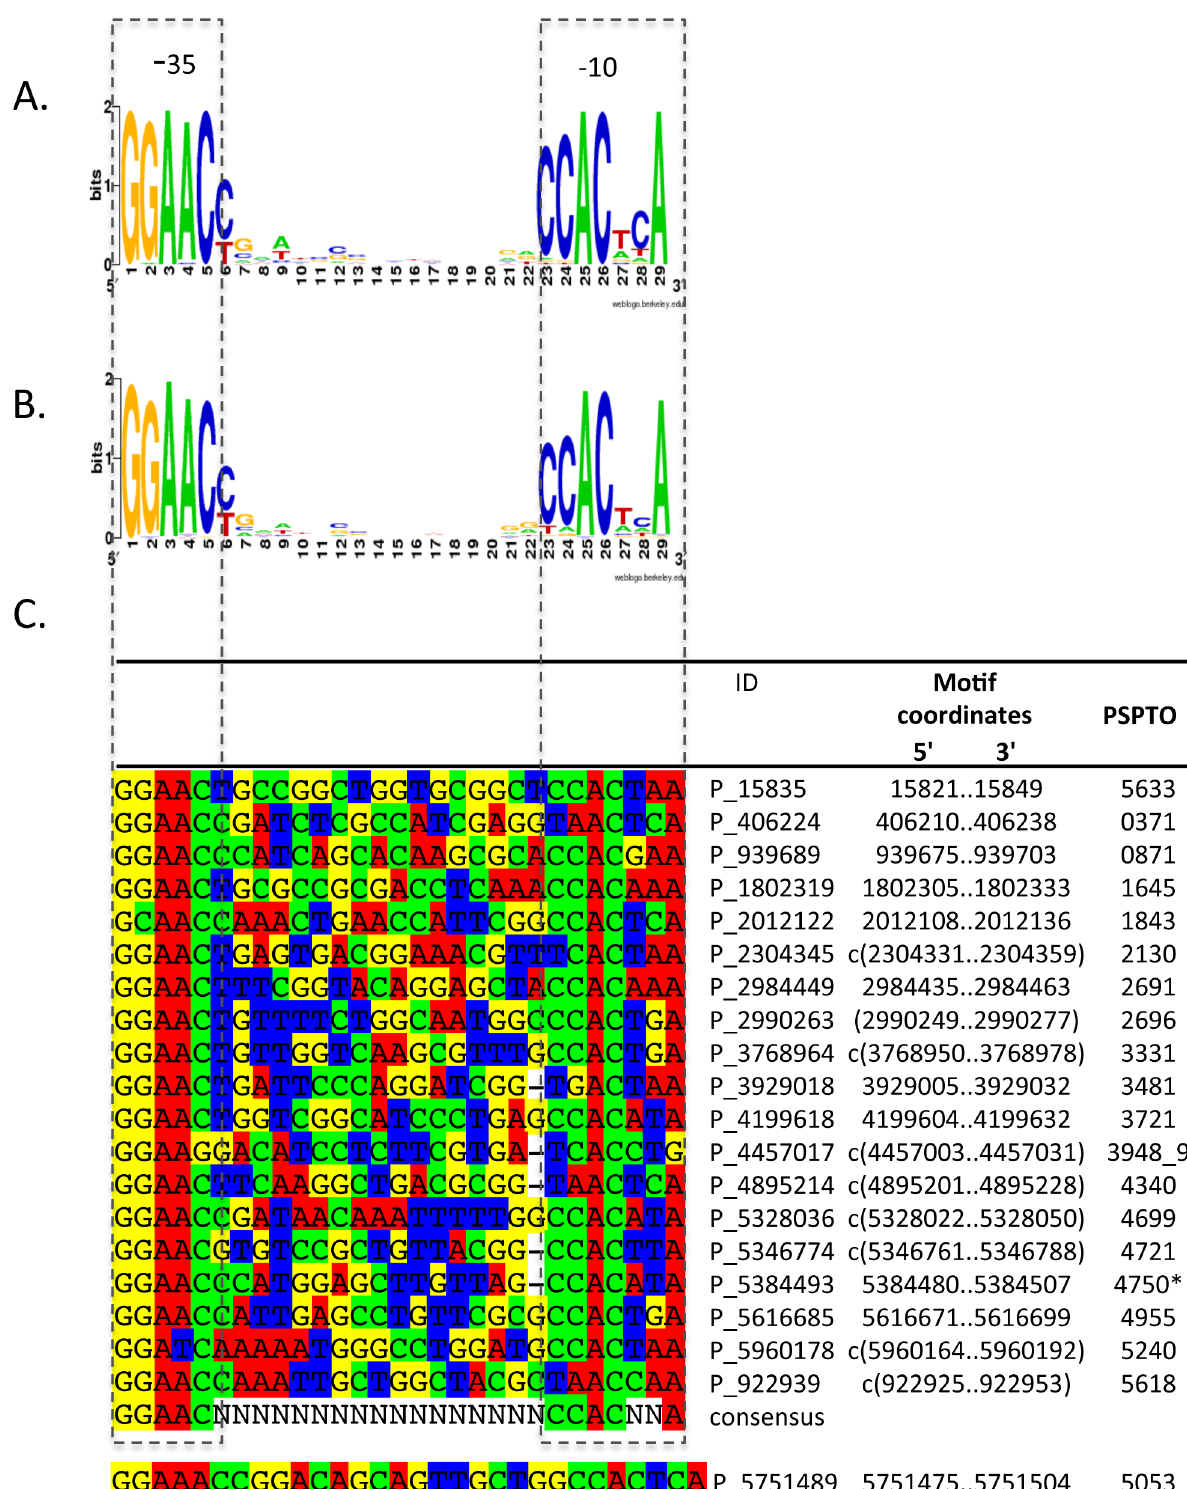
Figure 2. hrp promoter sequence alignment. (A). Motif logo for annotated hrp promoter sequences. (B). Motif logo for all hrp promoters including the newly identified set. The –35 region is highly conserved but two cytosines in the –10 region show variability. (C). Alignment of individual motifs sequences. Motif ID is the central position (genome coordinate) for the associated ChIP-Seq zone of enrichment. Genes downstream of hrp promoters are identified by PSPTO numbers. (*): Candidate hrp promoter is oriented in an antisense direction relative to PSPTO_4750. PSPTO_3948–9: candidate hrp promoter is between PSPTO_3948 and PSPTO_3949, which are oriented covergently. Motif logos were created by Weblogo [75]. Sequences were aligned and visualized using SeaView [76].